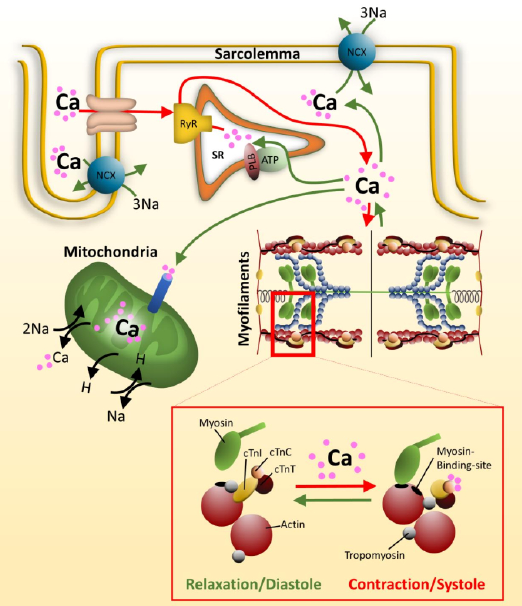
Figure 3. Role of Calcium in contractility. Voltage gated Ca 2+ -channels, located within T-tubuli, open upon depolarization of the sarcolemma. The resulting Ca 2+ -influx activates the nearby ryanodine receptors (RyR) of the sarcoplasmatic reticulum (SR), releasing Ca 2+ from the SR. Ca 2+ now binds to the Ca 2+ -sensor of the sarcomere, cardiac troponin C (cTnC), which forms together with cTnI and cTnT the troponin complex (see insert). Ca 2+ -saturation of cTnC triggers conformational changes within the troponin complex, releasing cTnI from actin. This enables tropomyosin to roll over on the actin filament to demask the myosin binding sites, and force production occurs. At the same time, Ca 2+ is pumped back into the SR by a phospholamban (PLB) regulated SR Ca 2+ -ATPase, into the extracellular space by Na + /Ca 2+ exchanger (NCX) and into the mitochondria. As the cytoplasmic Ca 2+ -concentration reduces, Ca 2+ is released from cTnC, cTnI rebinds to actin and tropomyosin is forced back masking the myosin binding sites. The muscle relaxes. The figure was created using PowerPoint (Microsoft).